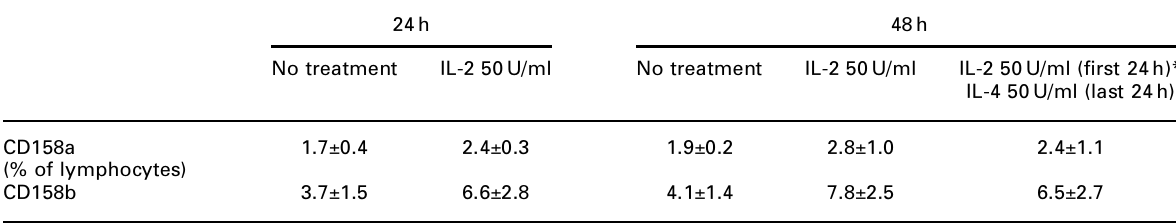
Table 2. The effect of IL-4 on the expression of KIRs on PBMC after treatment with IL-2